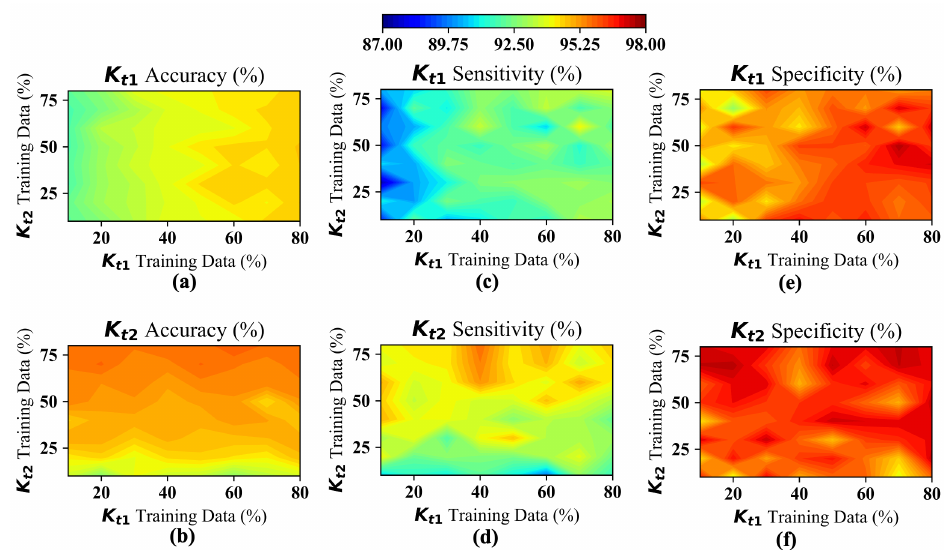
Figure 15. Contour plots showing variations in ( a , b ) Accuracy, ( c , d ) Sensitivity, and ( e , f ) Specificity for K t 1 and K t 2 ,